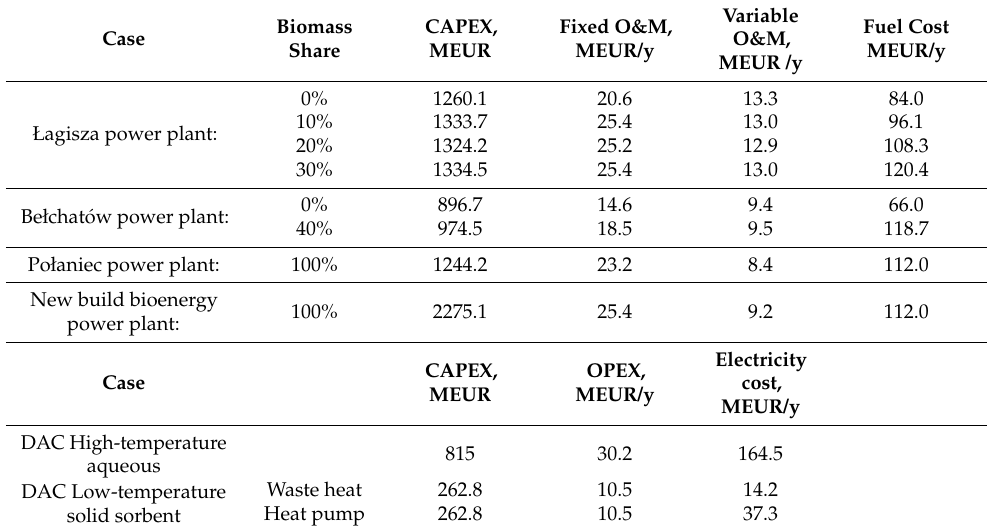
Table 9. Economic parameters of analyzed power plants (in